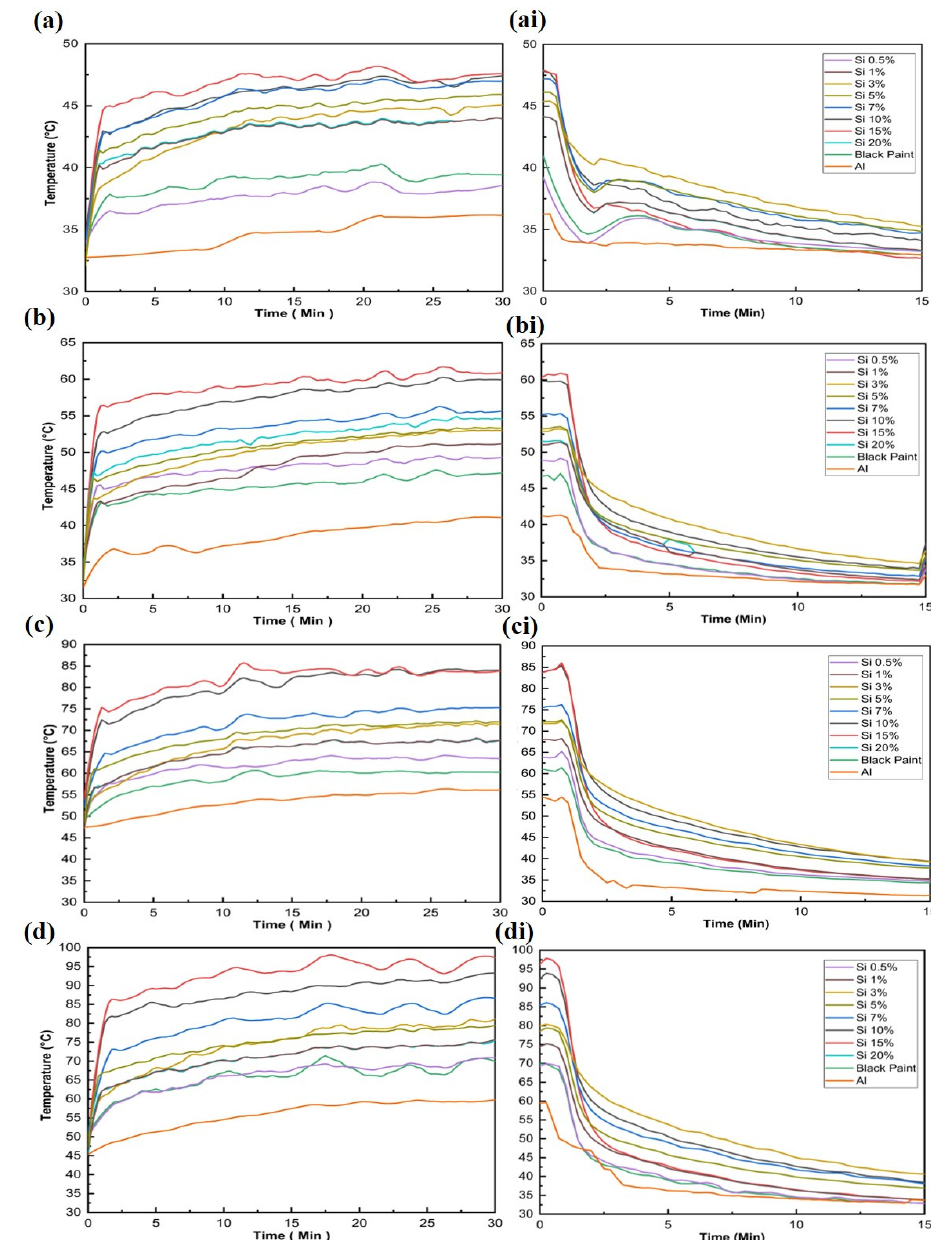
Figure 6. Effect on absorber temperature at an irradiation exposure of ( a ) 200 W/m 2 , ( b ) 400 W/m 2 , ( c ) 800 W/m 2 , and ( d ) 1000 W/m 2 , and the temperature-drop profile ( ai – di ). The maximum temperature measured for specimens containing 0.5 wt% Si at 1000 W/m 2 irradiations was 72.8 °C, which is 22.58% higher compared to bare aluminum plate and 1.39% higher compared to the black paint-coated aluminum plate. Specimens con- taining 1 wt%, 3 wt%, 5 wt%, 7 wt%, and 10 wt% exhibited the maximum temperatures of approximately 75.6 °C, 79.3 °C, 81.7 °C, 87.8 °C, and 93.4 °C, respectively. The highest temperature was attained in the case of specimens containing 15 wt% Si at a 1000 W/m 2